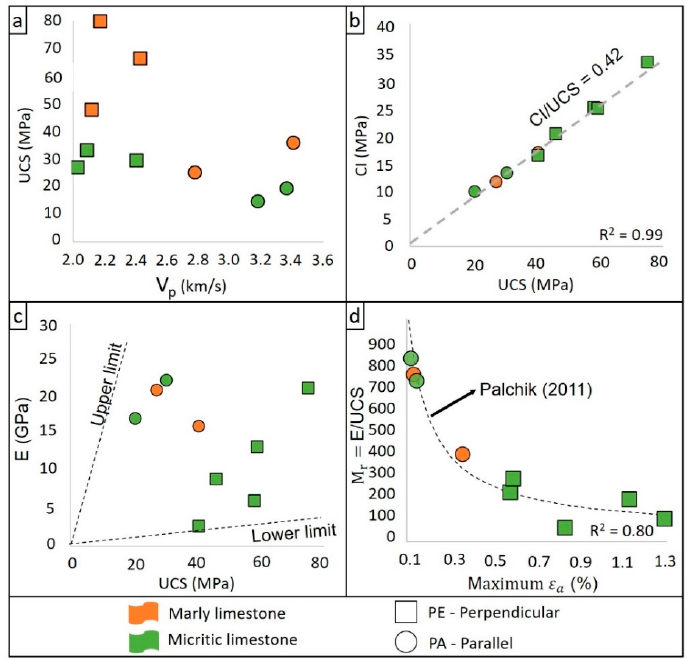
Figure 9. Correlation between parameters measured in this research. Symbols for geotechnical prop- erties are illustrated in Table 4. ( a )Unconfined compressive strength versus P-wave velocity; ( b ) crack initiation versus unconfined compressive strength ( c ) Young’s modulus versus unconfined compressive strength. Upper and lower limits for UCS vs. E are plotted (Hoek and Diederichs [85]; ( d ) modulus ratio versus maximum axial strain. Correlation of data plotted as dashed line (Palchik [86]).